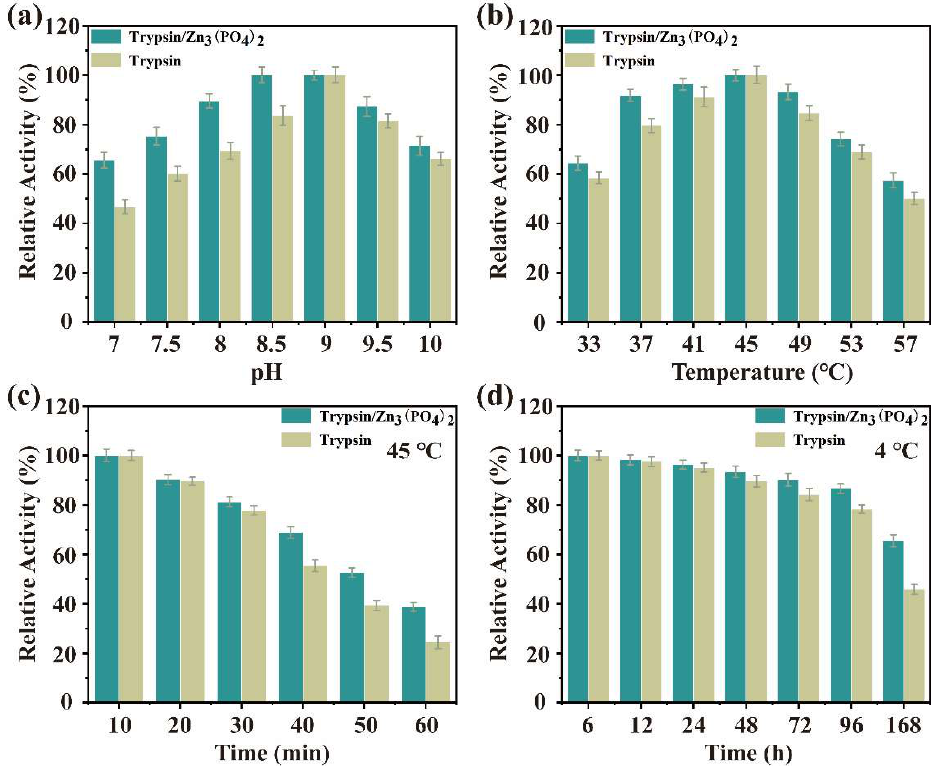
Figure 6. Effect of pH ( a ) and temperature ( b ) on the catalytic activity of trypsin/Zn 3 (PO 4 ) 2 hybrid nanoflowers; thermo ( c ) and storage ( d ) stability of trypsin/Zn 3 (PO 4 ) 2 hybrid nanoflowers. Data are presented as mean ± SD (n = 3).